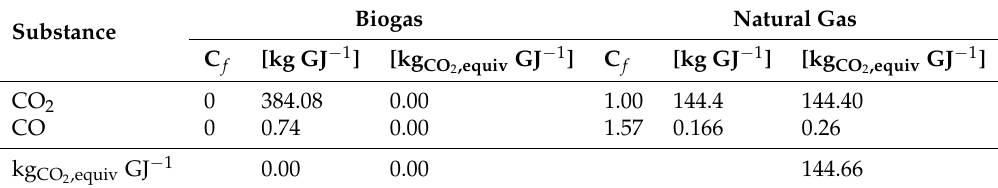
Table 20. Damage assessment of emissions belonging to Global Warming